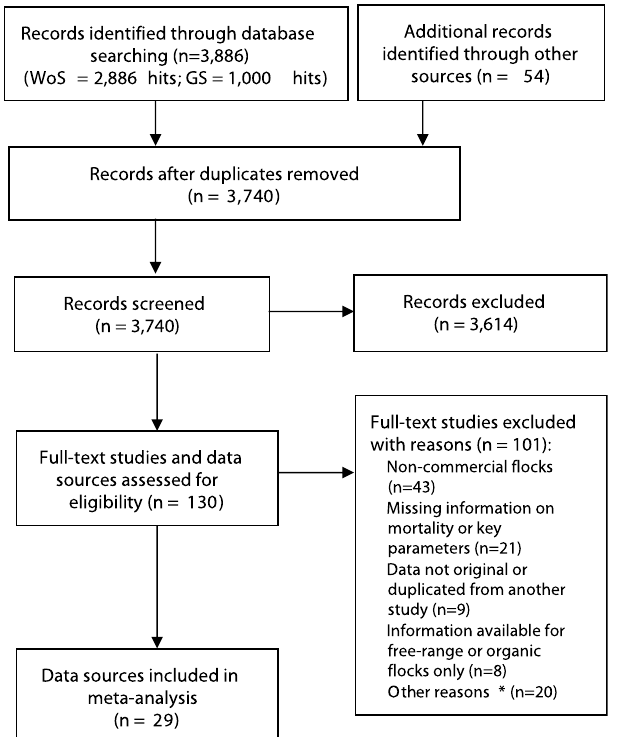
Figure 2. Flow diagram of selection process. Screening was conducted with the software JabRef version 5.0 (https ://www.jabre f.org). *A list with the reason for exclusion for each of the full-text papers screened is provided in the Supplementary Table